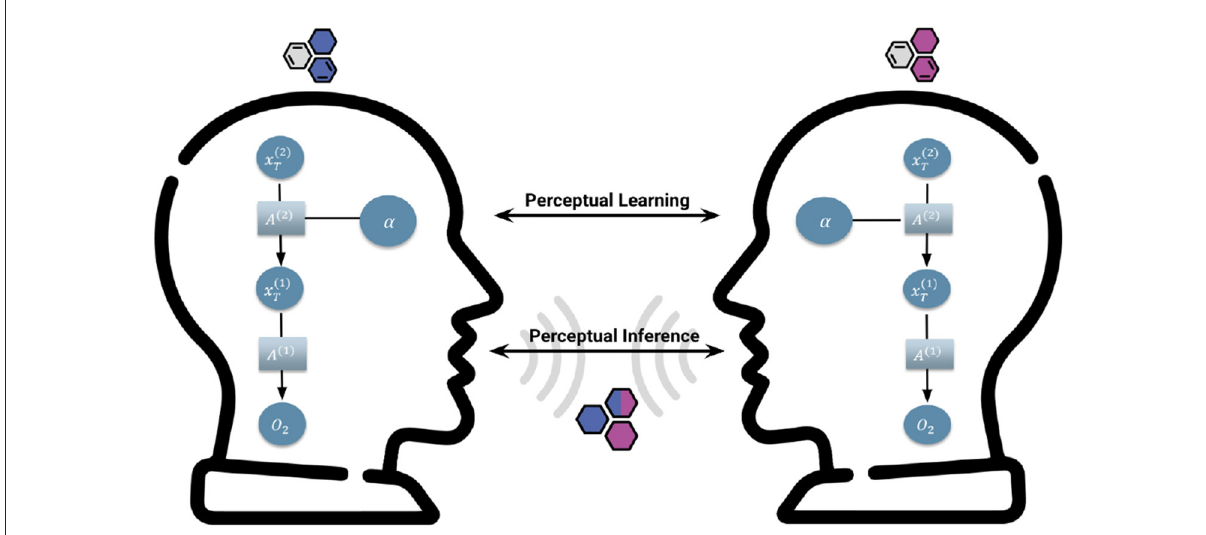
FIGURE1 Communication Coupling Parameters. Our model defines two groups of parameters that couple the internal states of agents: Learning and inference. Perceptual learning (A2) is the learning of associations between emotional valence and belief states that guide the long term actions of our agents who hold and express beliefs. This learning happens at slow time scales, accumulating across multiple interactions and used to modify models over extended periods of exchange. Perceptual Inference (A1)—namely, sensitivity to model evidence—operates on fast time scales and is direct and explicit to agents during dialogue. Importantly, we hypothesized that without precise evidence accumulation, agents would be insensitive to evidence regarding the belief state of the other, and their internal states would not